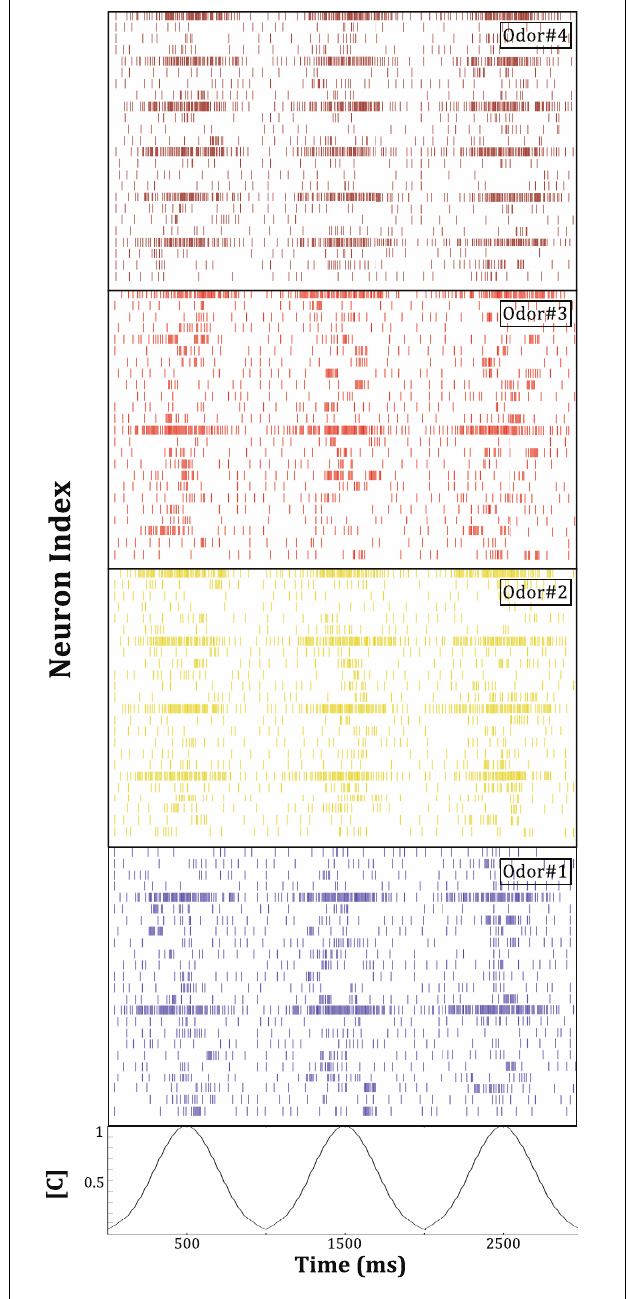
FIGURE 12 | Mitral cell population activity in the chip in response to the presentation of four different odors. This activity constitutes the final output of the system in its present configuration. Spiking patterns from 24 of the 48 mitral cells on the chip are depicted. Odorant concentration [C] was modulated as depicted at the bottom of the figure. Compared to the primary representation of the chemical environment by the broadly tuned, concentration-sensitive population of simulated sensors driving the chip, this secondary representation is more sharply tuned, normalized, and exhibits an increased signal-to-noise ratio. For final odor identification and discrimination, this output activity can be sent to a standard pattern recognition engine, or to biomimetic circuits representing higher processing stages in olfactory